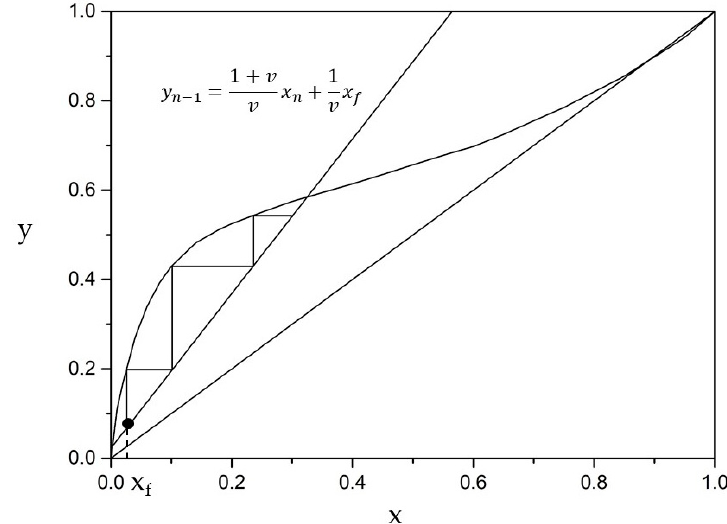
Figure 4. The number of theoretical plate determination by graphic method .